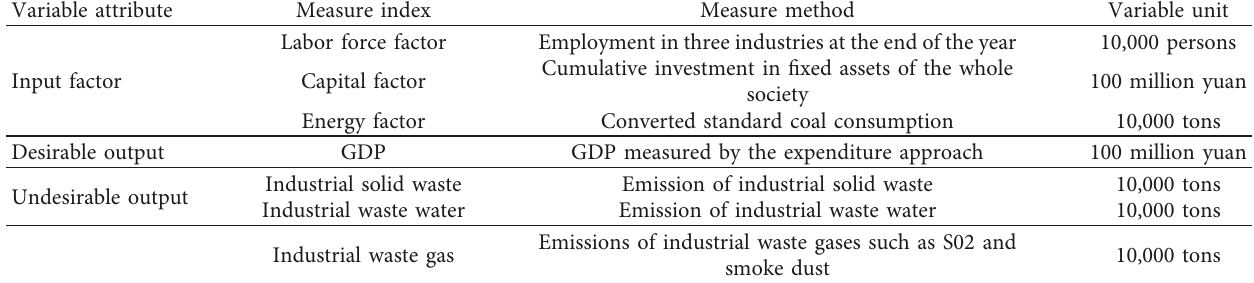
Table 1: Input and output variables.